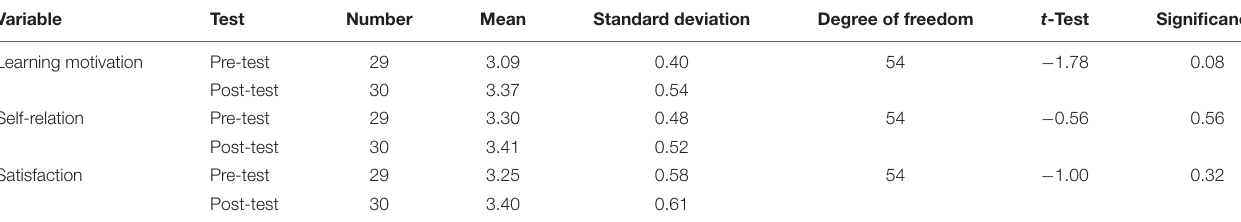
TABLE 12 | ARCS Learning Motivation Scale post-measurement repeat measurement t- test